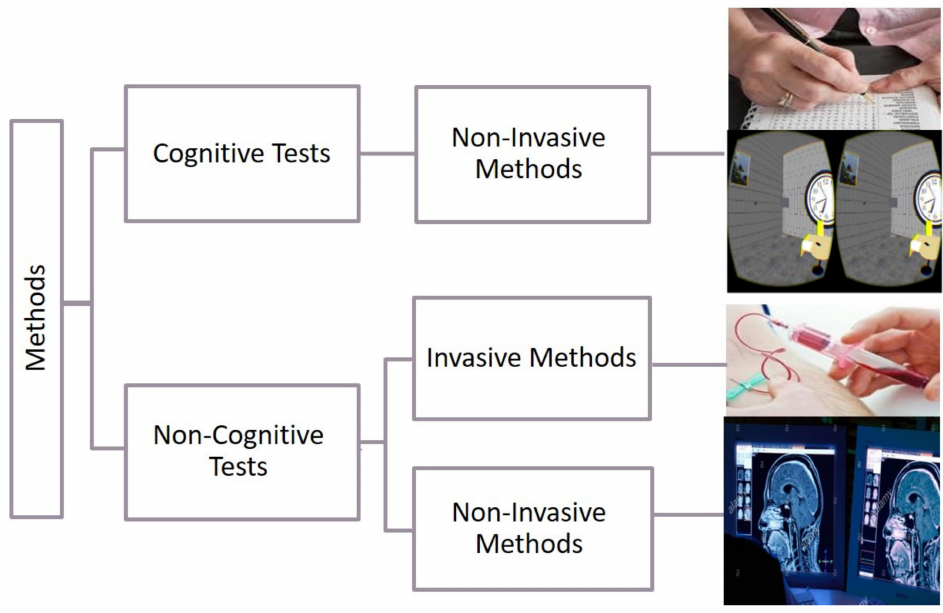
Figure 1. Classification methods to detect cognitive impairment